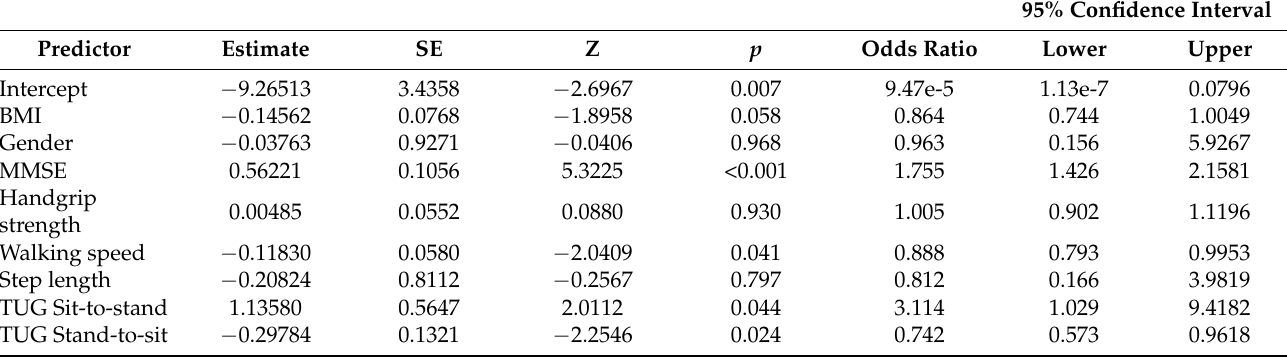
Note. Estimates represent the log odds of “Cognitive Impairment = MCI” vs. “Cognitive Impairment =